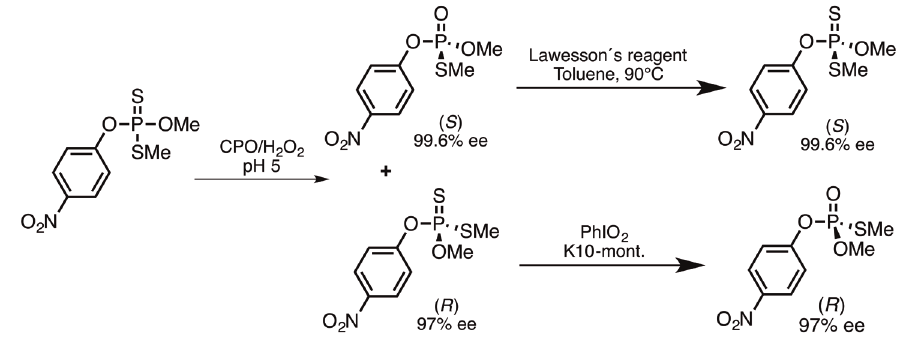
Figure 38 - Chemo-enzymatic synthesis of methyl parathion and its oxon.